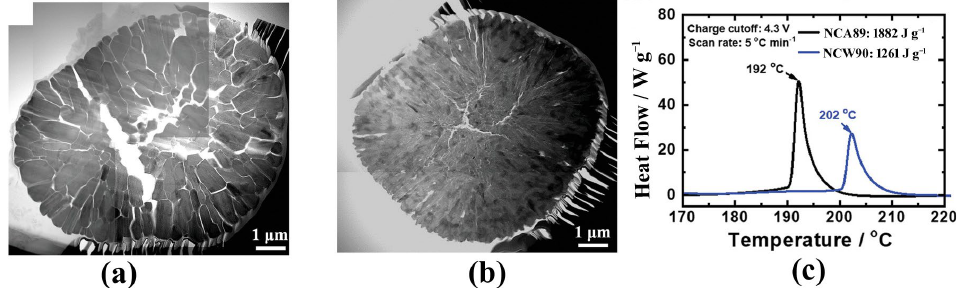
Figure 7. Bright-field STEM mosaic image of a cross-section of ( a ) NCA89 and ( b ) NCW90 at charged to 4.3 V, and ( c ) DSC profiles for NCA89 and NCW90 in the delithiated state at 4.3 V [52].